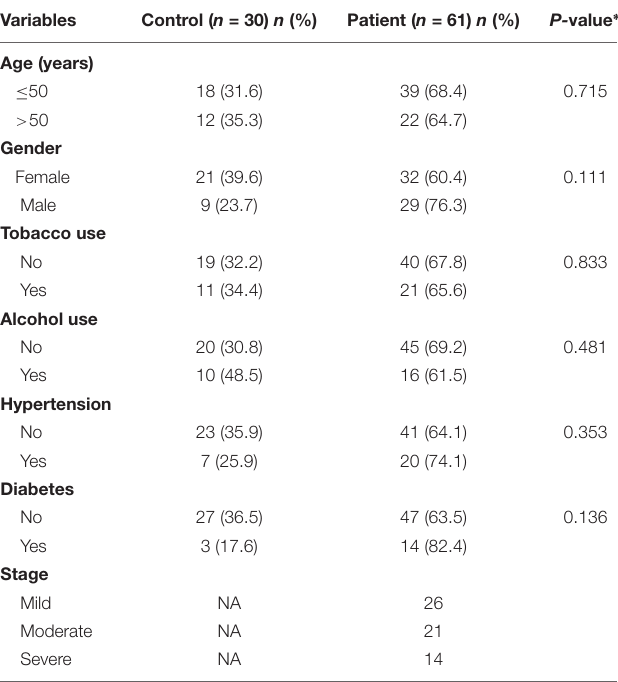
TABLE 1 | The demographics and clinicopathological characteristics of the periodontitis patients and control